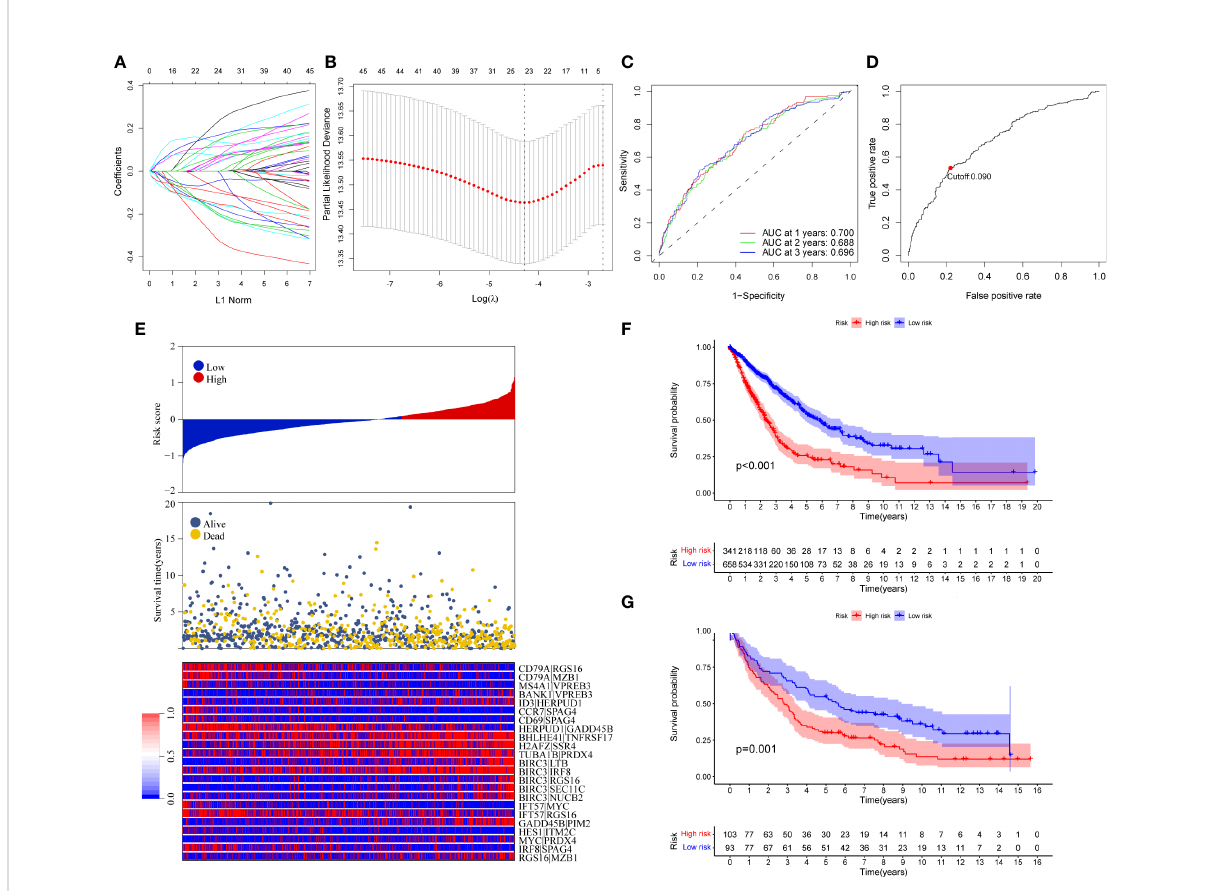
FIGURE 2 Construction and validation of BRGPs signature in NSCLC patients. (A) Trend graph of LASSO coef fi cients. (B) Partial likelihood deviation map. (C) ROC curve of 1-, 2- and 3-year survival predictions of BRGPs signature in the training cohort. (D) ROC curve of 3-year survival shows the optimal cut-off value of the risk score in the training cohort. (E) The distribution of BRGPs-based risk score, the vital statuses of patients and the heatmap of 23 BRGP pro fi les in the high- and low-risk groups. (F, G) Kaplan-Meier survival curves of OS in the training cohort (F) and validation cohort (G) based on risk score. BRGPs, B cell-related gene pairs; NSCLC, non-small cell lung cancer; ROC, receiver operating characteristic; OS, overall